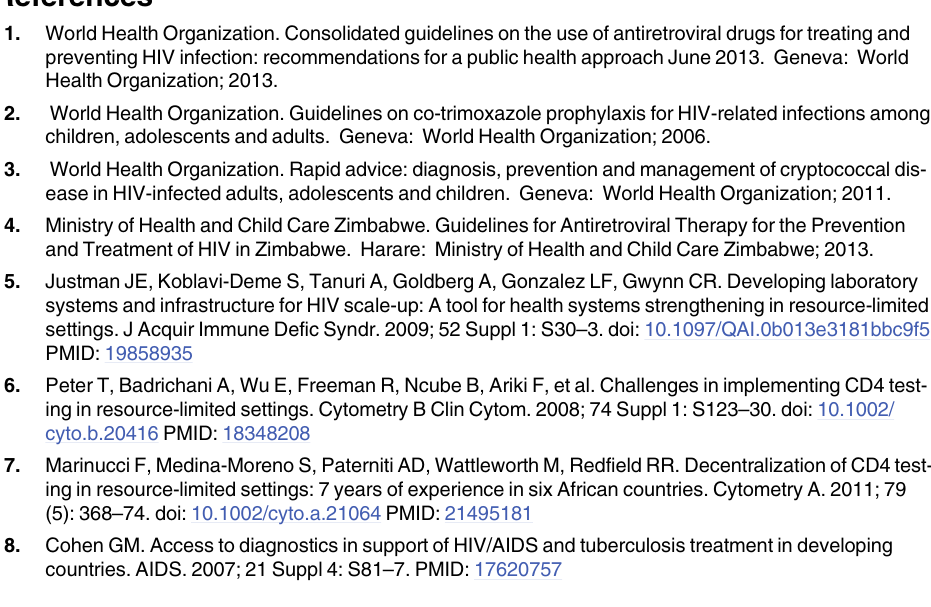
S1 Table. Agreement of BD Vacutainer CD4 Stabilization Tube sample results on BD Facs-